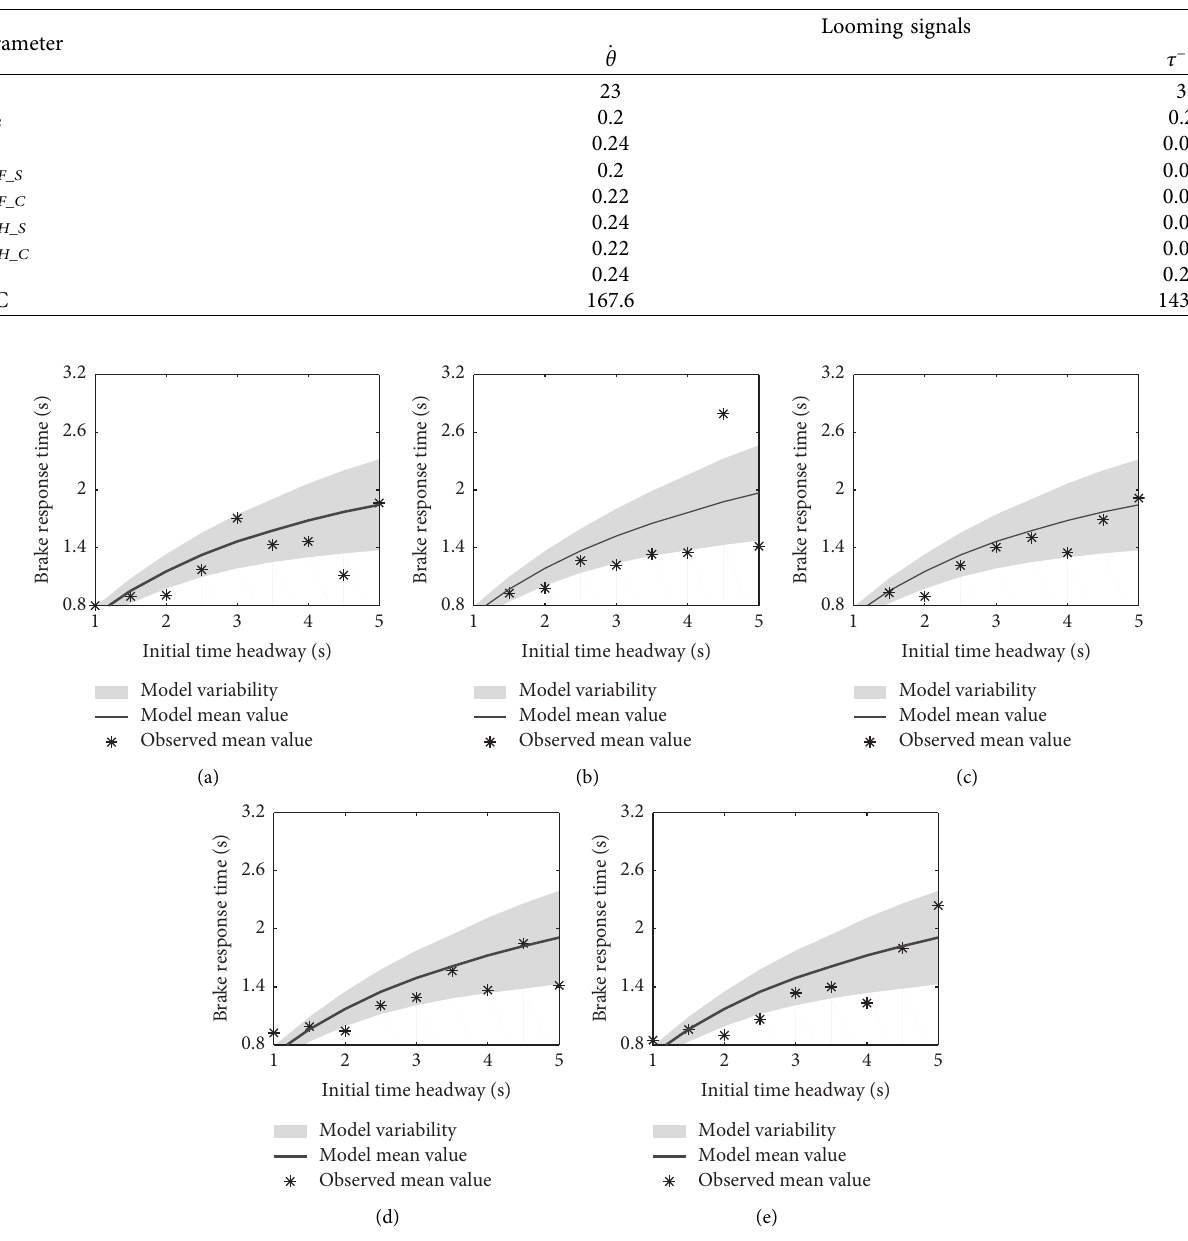
Figure 9: Simulation results versus observations obtained from simulator experiments, using _ θ . (a) No phone. (b) Hands-free (simple). (c) Handheld (simple). (d) Hands-free (complex). (e) Handheld